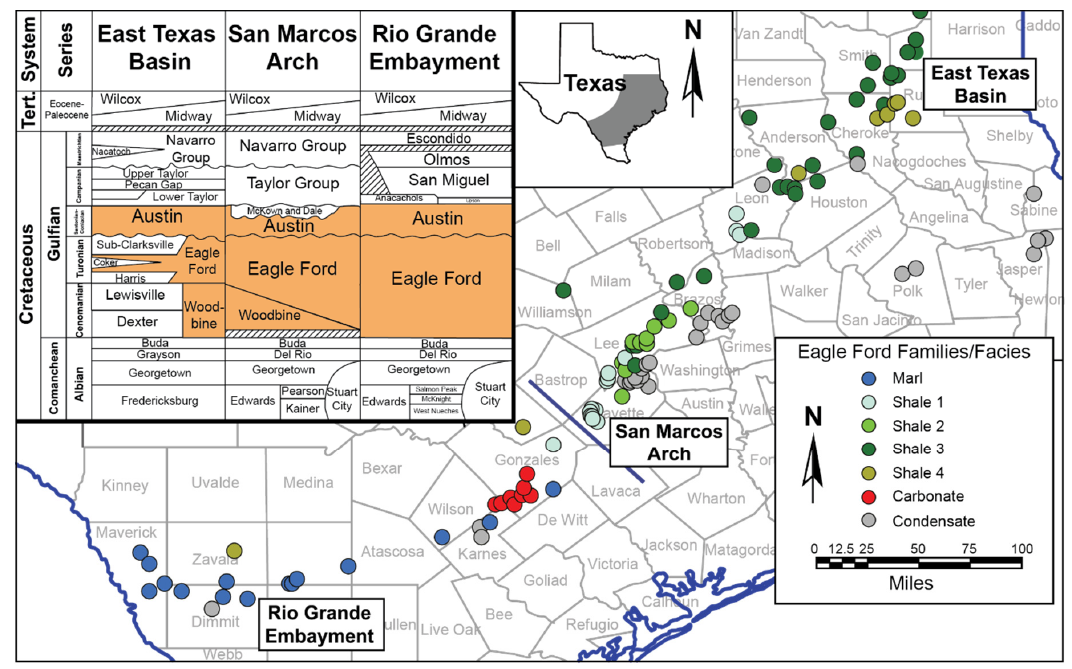
Figure 9. Location map showing the extent and range of the Eagle Ford Play across Texas. The Play can be broken down into three sections moving from East to West–East Texas Basin, San Marcos Arch and Rio Grande Embayment–with slightly differing stratigraphy, all of which contain the Upper Cretaceous Eagle Ford and Austin Chalk Formations. The location map also highlights the regional Eagle Ford sourced oils [38], color coded by oil family definition as a result of geographic facies variations across the play.